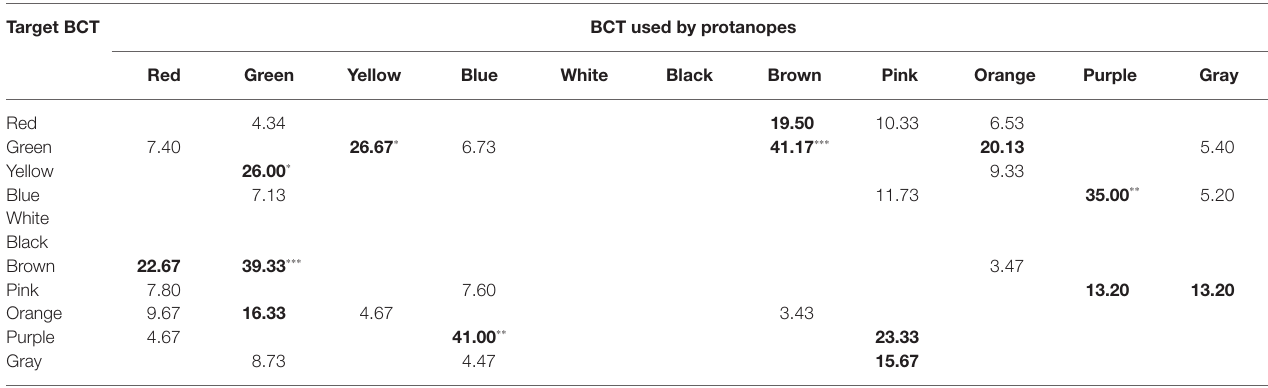
TABLE 3 | Protanope confusion matrix obtained in the verbal task. Target BCT BCT used by